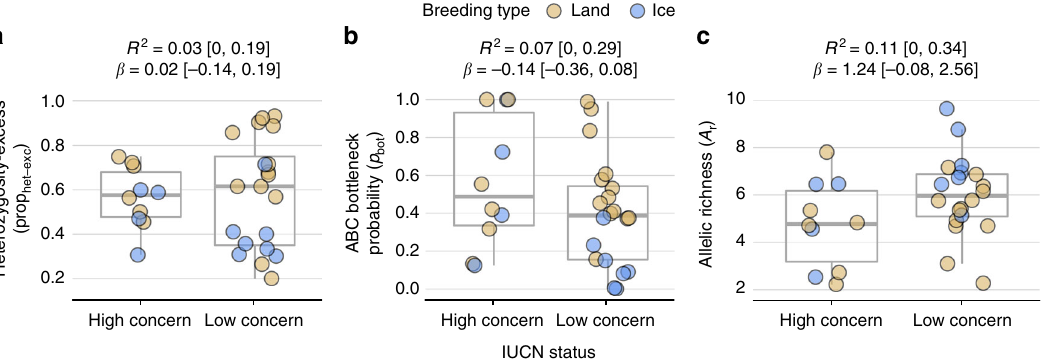
Fig. 5 Conservation implications of bottlenecks and genetic diversity. All pinniped species were classi fi ed into either a ‘ low concern ’ or a ‘ high concern ’ category depending on their current IUCN status as described in the main text. Shown are the raw data for each category together with boxplots (centre line = median, bounds of box = 25th and 75th percentiles, upper and lower whiskers = largest and smallest value but no further than 1.5 * inter-quartile range from the hinge) for a prop het-exc , b p bot . and c A r . Marginal R 2 and standardised β estimates are shown for Bayesian phylogenetic mixed models with standardized predictors (see Methods for